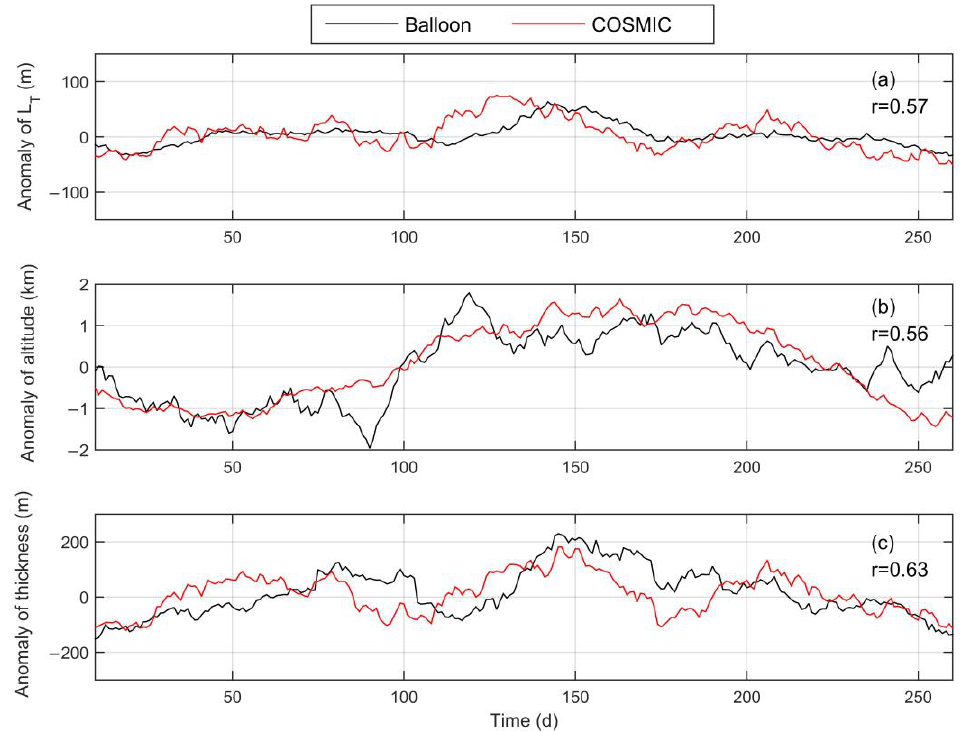
Figure 1. Anomalies of L T ( a ), altitude ( b ) and thickness ( c ) obtained from the two sorts of data respectively. Table 1. Comparison of statistical characteristics of L T , altitude and thickness obtained from the two sorts of data.